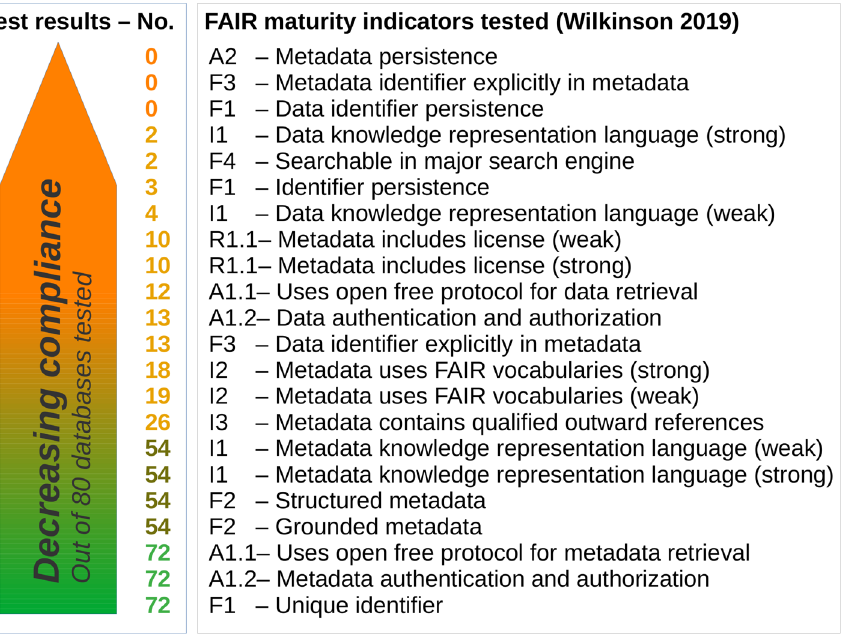
Figure 3. Number of databases complying with FAIR maturity indicators as operationalized in Wilkinson et al. 2,43 that test 13 of 15 FAIR principles. The results are based on machine-actionability tests for 80 databases that are representative of data flows for low carbon energy research. None of the tested databases achieves persistence of metadata and data identifiers. Internal linking of metadata with the help of identifiers is equally